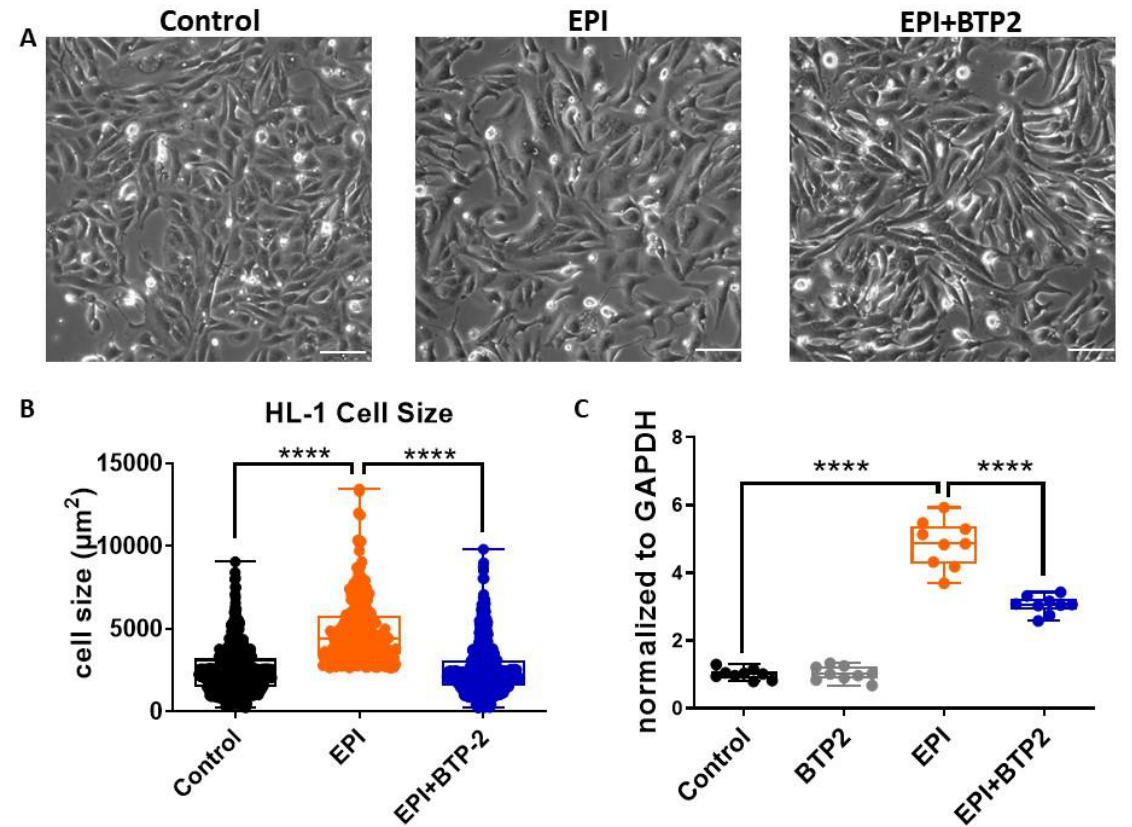
Figure 5. BTP2 inhibited EPI-induced hypertrophy in HL-1 cardiomyocytes. HL-1 cells treated with 1 µ M EPI for 5 h followed by fresh media culture for 24 h. ( A ) Phase contrast images of HL-1 cells treated with 1 µ M EPI (EPI), 1 µ M EPI together with 20 µ M BTP2 (EPI + BTP-2), or vehicle-treated control (control). Scale bar, 50 µ m. ( B ) Quantification of the cell surface area of HL-1 cardiomyocytes. Mean ± SEM, n ≥ 581 per group. ****: p < 0.0001 (based on one-way ANOVA and Bonferroni post hoc analysis). ( C ) BTP2 reduced hypertrophy marker BNP transcript in HL-1 cardiomyocytes. Quantitative reverse transcription PCR expression levels of BNP were normalized to GAPDH and plotted relative to the level in the vehicle-treated control cells. n = 9, triplicates from three independent experiment. Mean ± SD. ****: p < 0.0001 (based on one-way ANOVA and Bonferroni post hoc analysis).